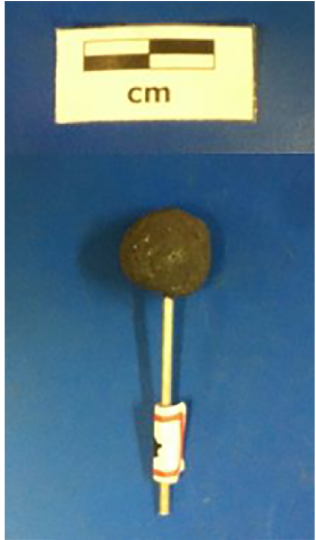
Figure 2. Sample for microCT analysis.